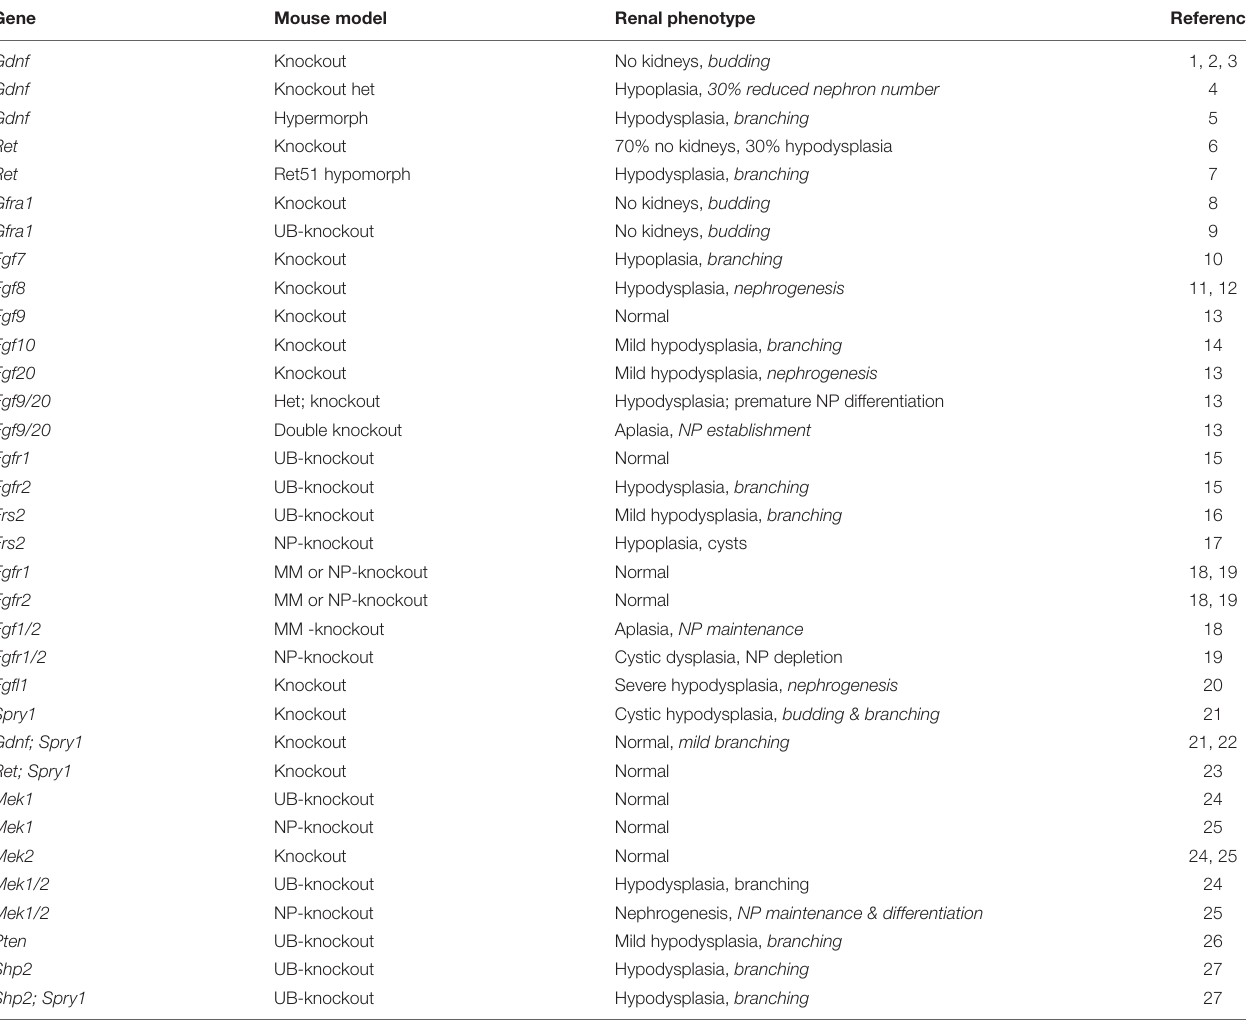
TABLE 1 | Phenotype in genetic models of trophic factors. Gene Mouse model Renal